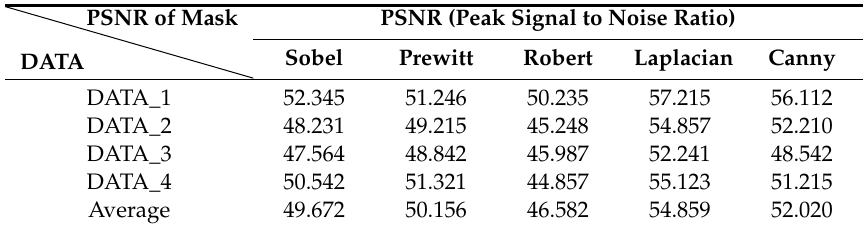
Table 1. The peak signal to noise ratio (PSNR) results according to the mask type.